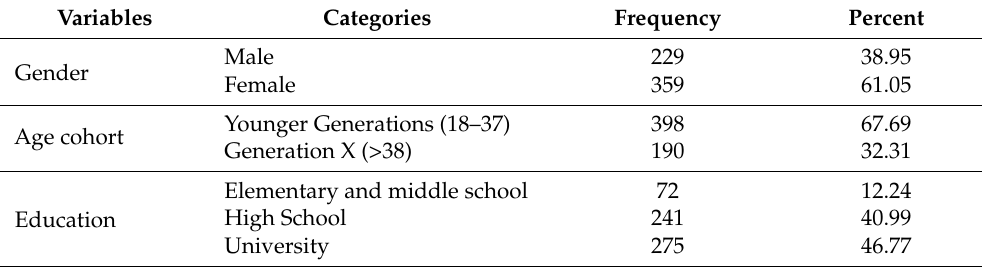
Table 1. Socio-demographic characteristics of the sample ( n =